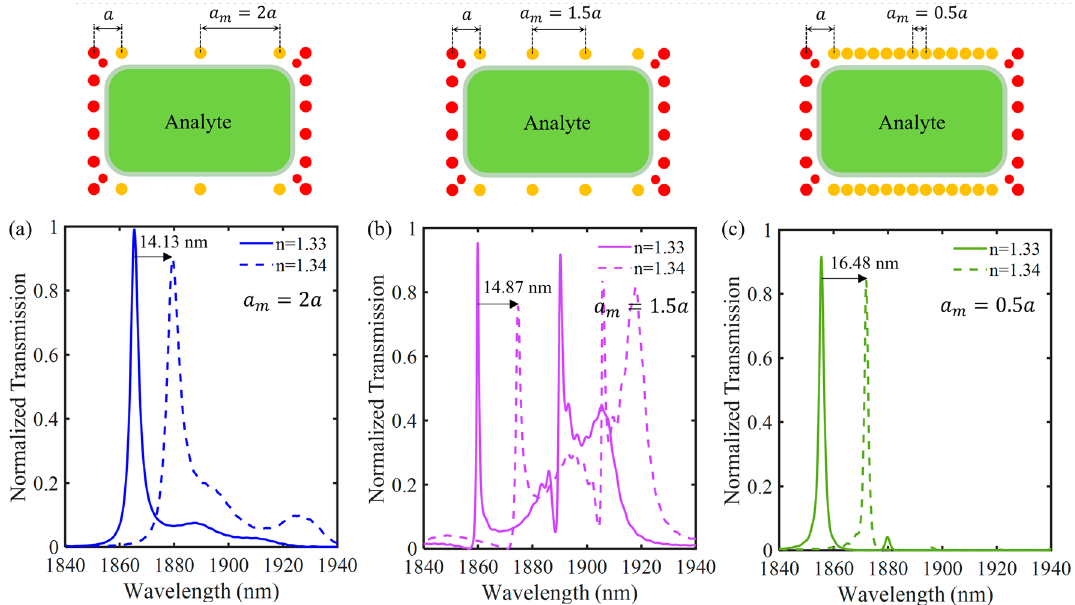
Figure 12. The normalized transmission spectrum as a function of the period of metallic rods for ( a ) a m = 2 a , ( b ) a m = 1.5 a and ( c ) a m = 0.5 a